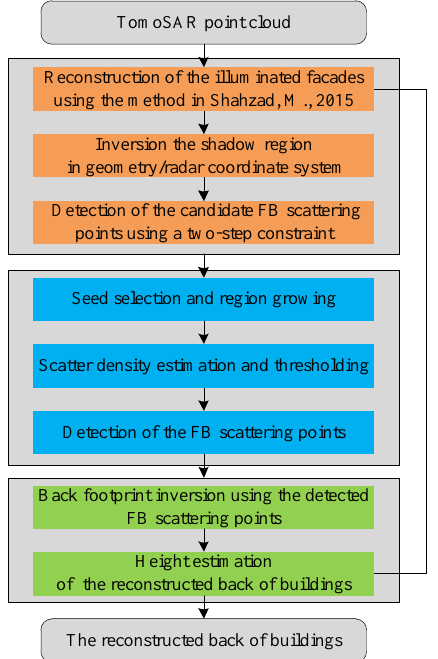
Figure 7. Workflow of the proposed method. Shahzad, M., 2015